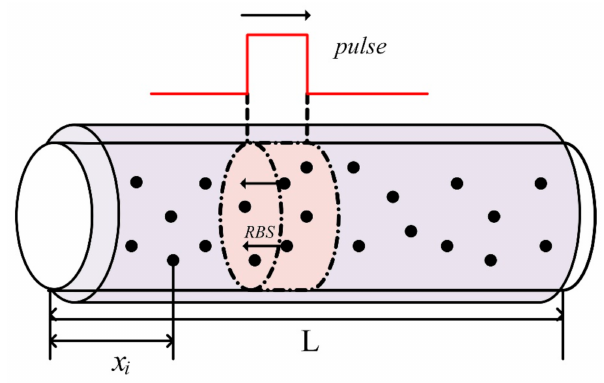
Figure 2. 1-D scattering model Schematic